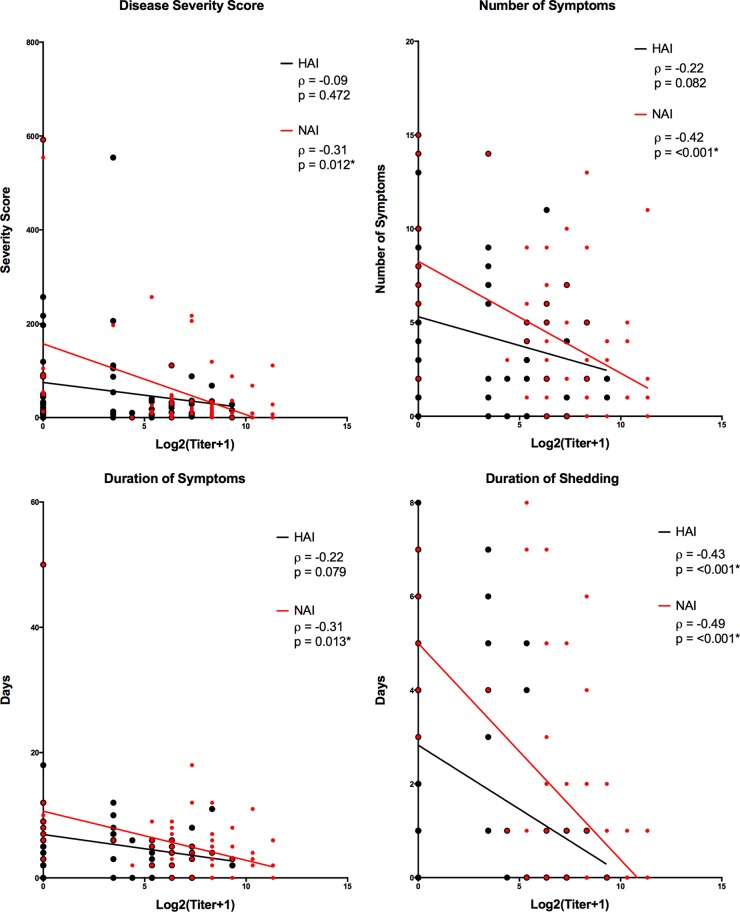
Linear correlation of baseline titer to disease severity measures. Two variable correlations were calculated using Spearman’s correlation coefficient between baseline HAI titer and all four disease severity measures (black), as well as between baseline NAI titers and all four disease severity measures (red). (Overlapping red and black points cause the red symbol to appear larger due to the presence of a black symbol in the same location.)